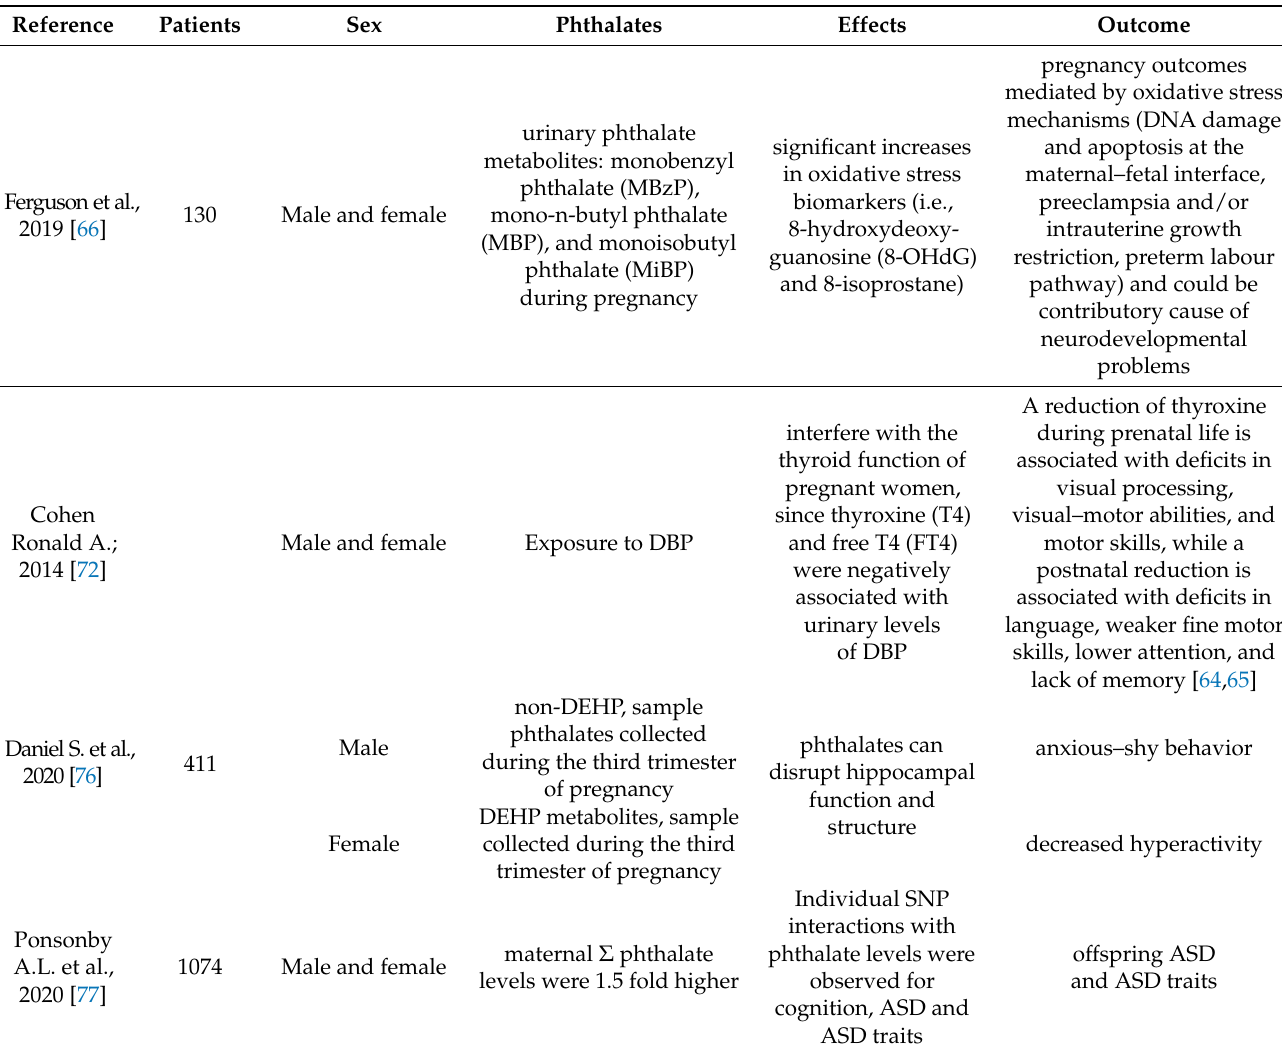
Table 2. Phthalate neurological